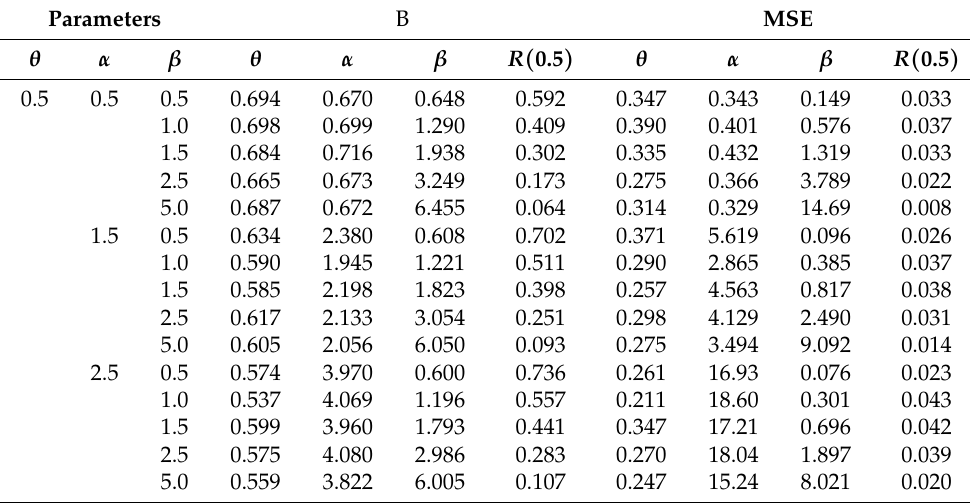
Table 1. The AVs of estimates and the corresponding MSEs for n =